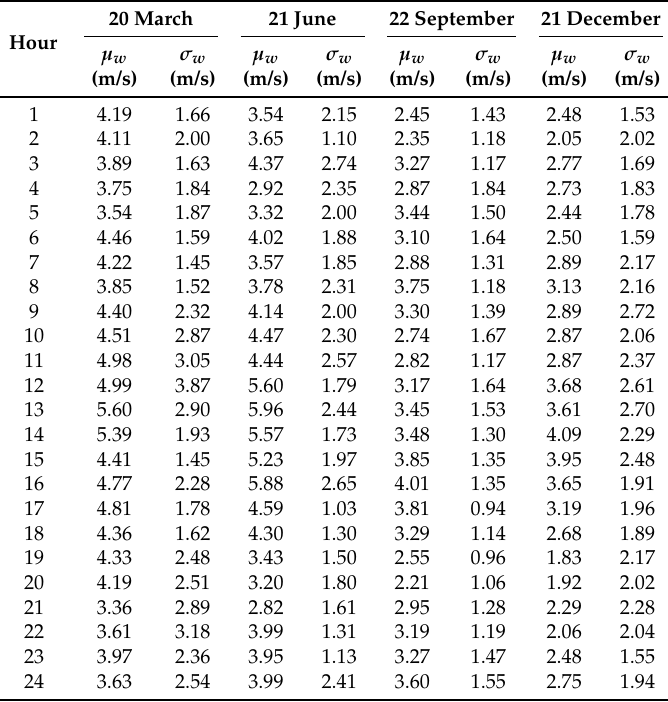
Table A5. Wind speed parameters (mean and standard deviation) on four different days.